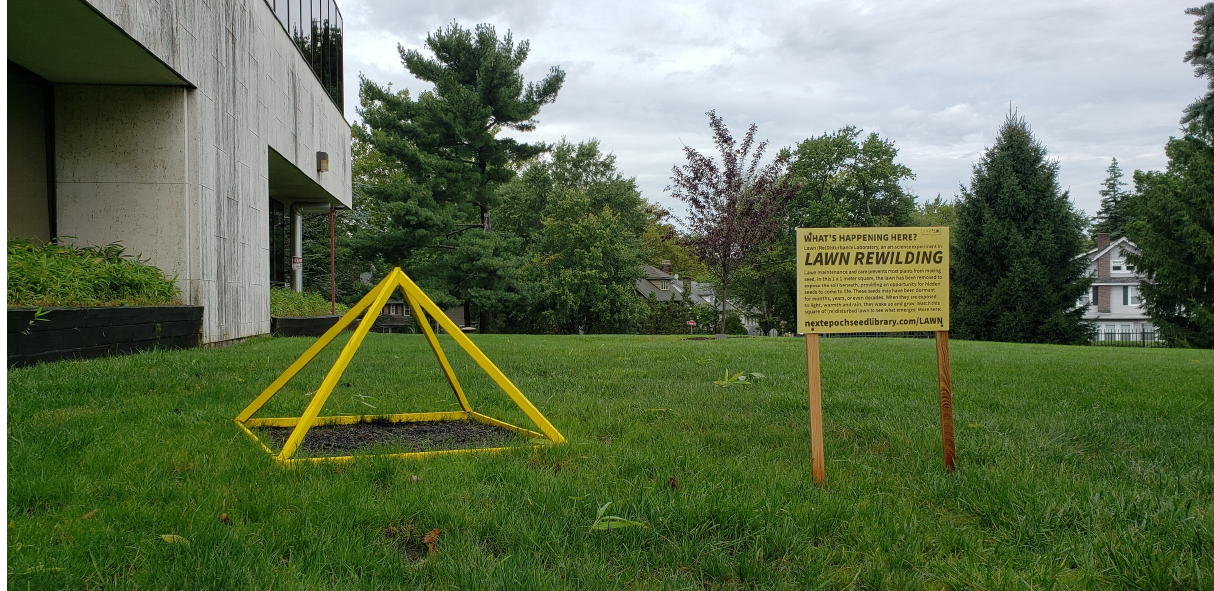
Figure 17: A freshly (re)disturbed Lawn Lab 2019 plot (season 2), on the grounds of Seton Hall University in Jersey City, New Jersey. For the second season of Lawn Lab we experimented with marking off plots with yellow pyramid structures built from scrap wood, meant to echo our logo, in this case representing the presence seeds above ground (on plants) and below ground (in the soil seed bank). We are developing this sculptural form further in the 2020 season of the